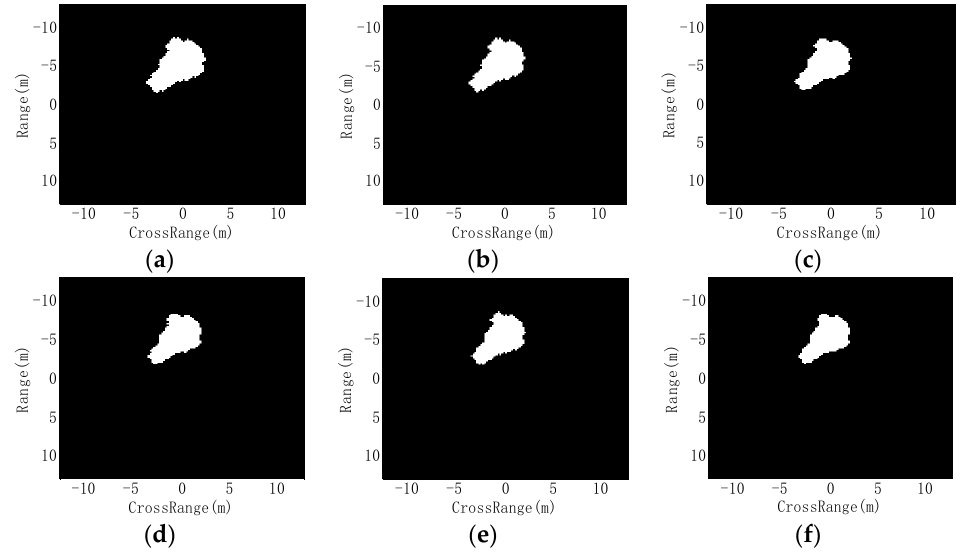
Figure 9. Distorted shadow under different structuring elements: ( a ) original shadow; ( b ) S1; ( c ) S2; ( d ) S3; ( e ) S4; and ( f ) S5. Table 10. The PCCs under segmentation errors (%).